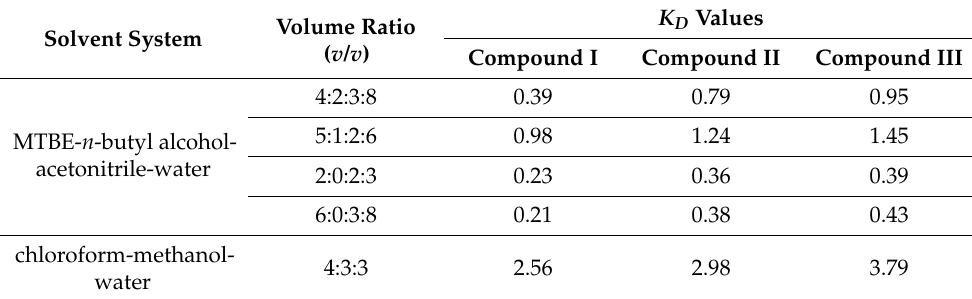
Table 1. The K D values of three compounds in different solvent